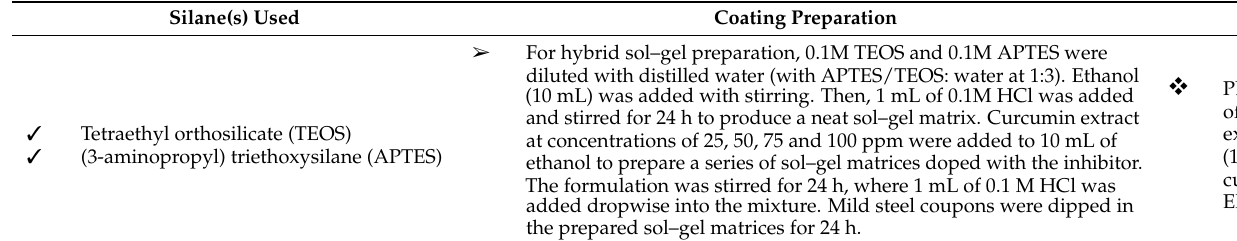
Table 1. Different approaches for improving silane coatings and the main findings, as reported in the literature. Coating Preparation Main Findings